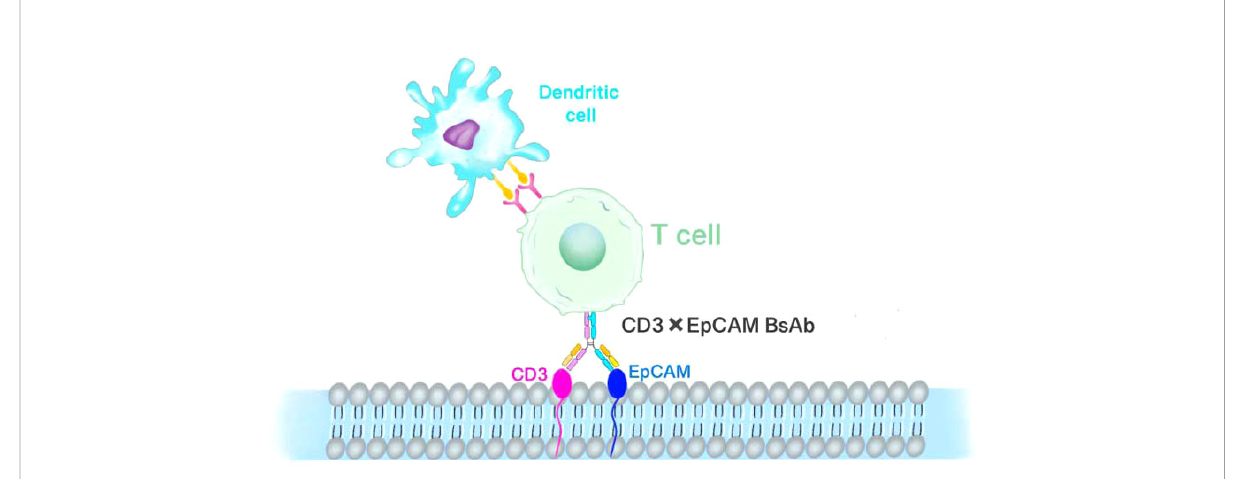
FIGURE 4 T-cell-mediated immunotherapy of EpCAM. EpCAM and CD3 bispeci fi c antibodies redirect T lymphocytes to attack retinoblastoma